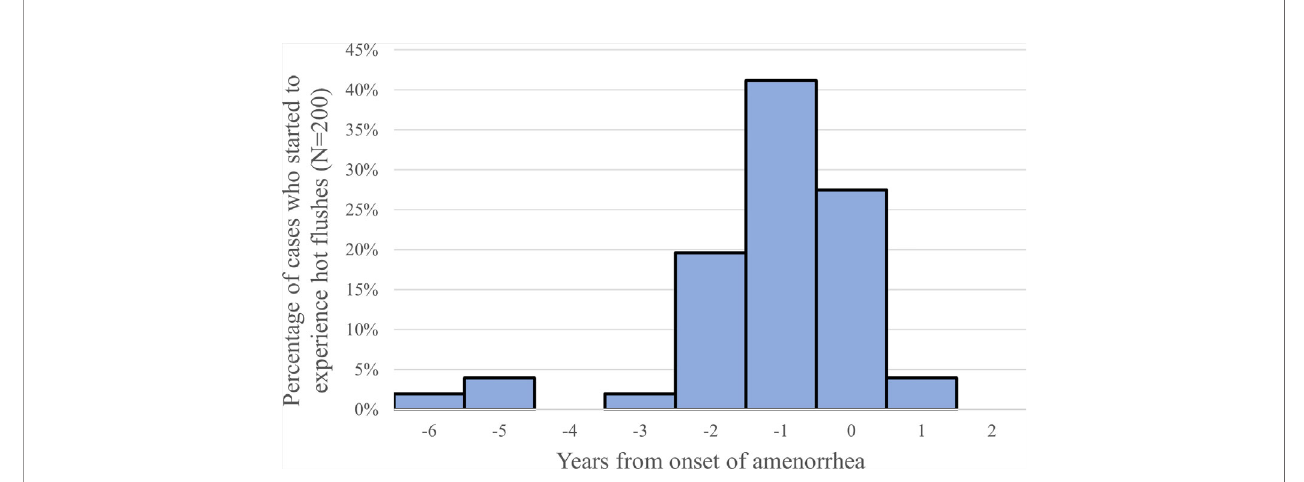
FIGURE 2 | Timing of onset of hot fl ushes (year from the onset of amenorrhea), 66% (132/200) of the POI patients reported the experience of hot fl ushes